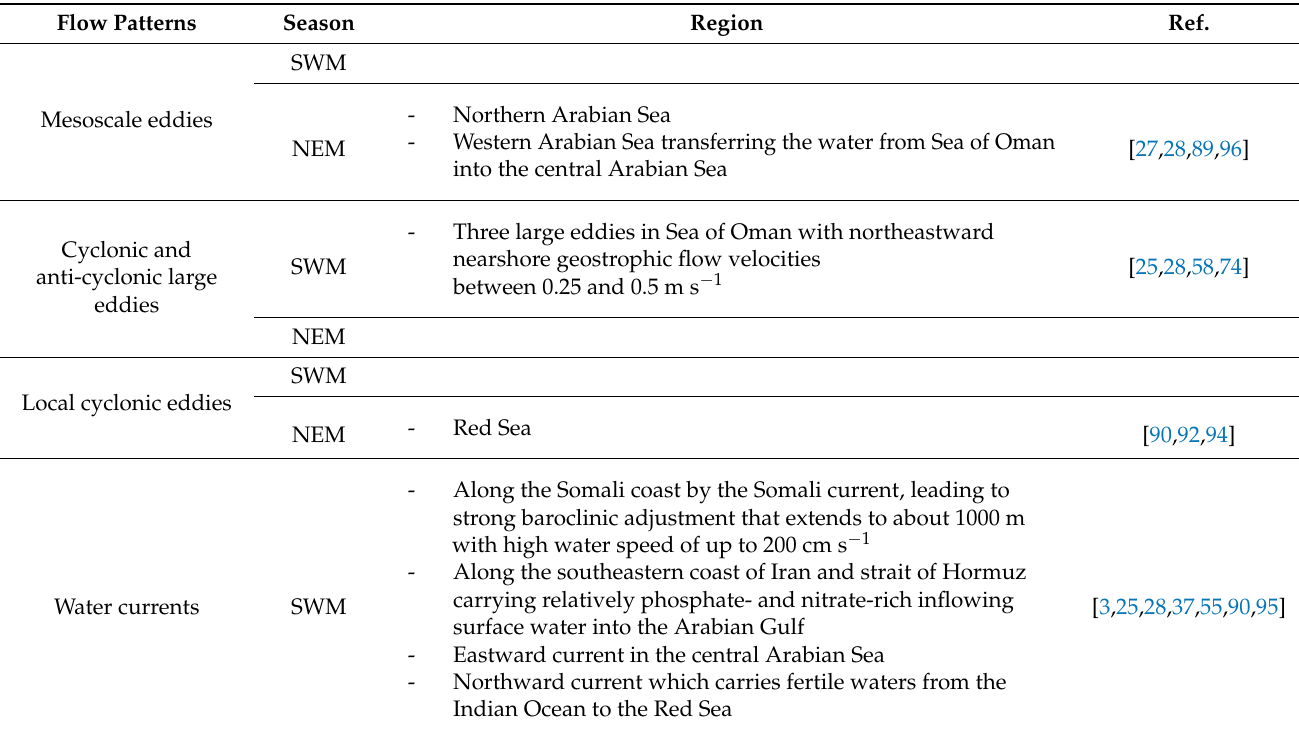
Table 5. Circulation forms in